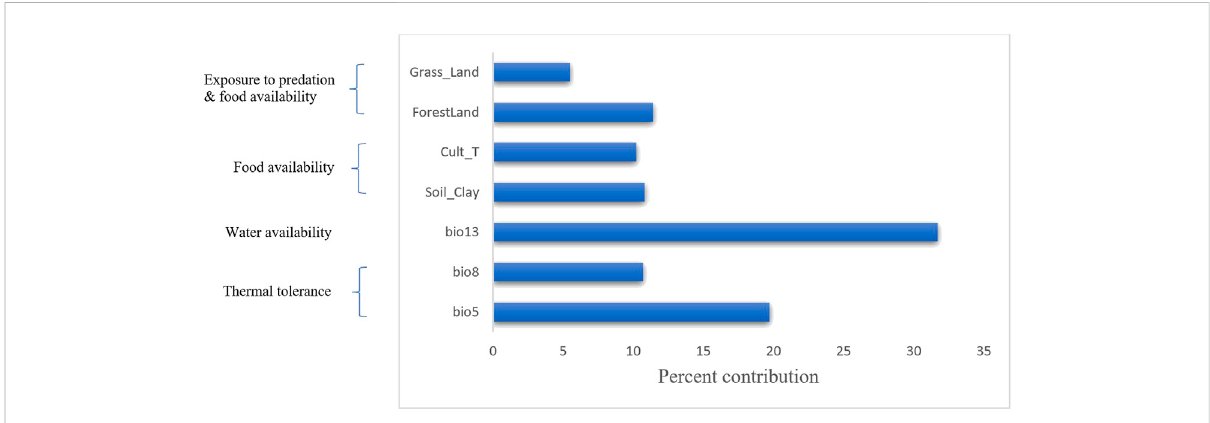
FIGURE 5 Percentcontributionofthe fi nalselectedsevenvariablesusingMVS.Theleft-handsideofthediagramshowsthebiologicalimportanceofthese variables to environmental adaptation in